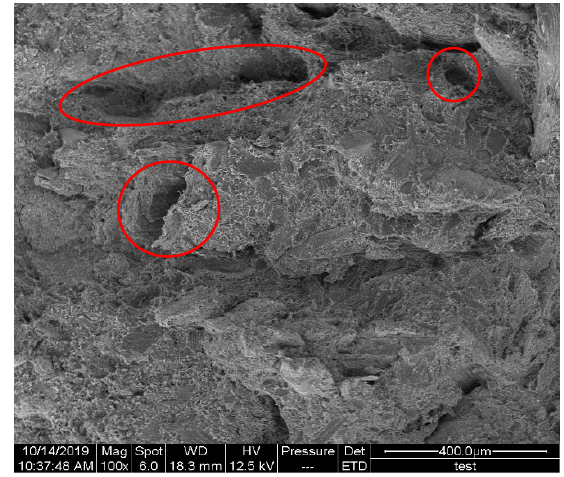
Figure 8. SEM of fracture surface of the extruded straw/LLDPE composite.